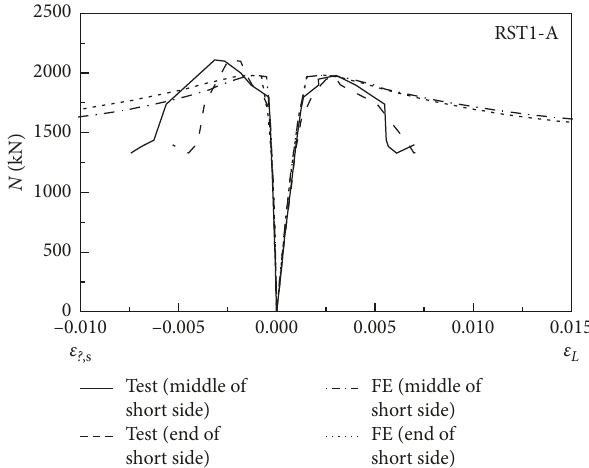
Figure 9: Comparison of N - ε curves obtained from numerical and experimental